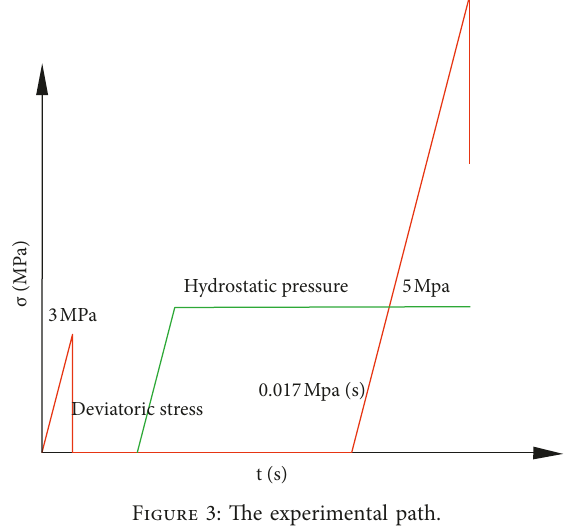
Figure 3: The experimental path.